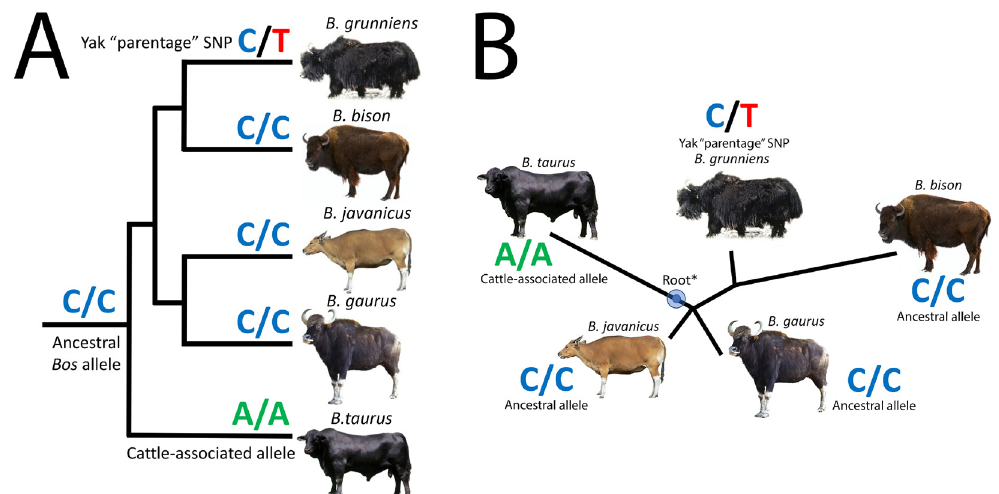
Figure 1. Hypothetical genotype distributions of a specialized triallelic SNP for determining yak parentage and estimating B. taurus introgression. Bos species trees are based on those published by Wu et al . (Wu et al ., 2018. Nat Ecol Evol 2, 1139–45). ( A ) Tree based on whole autosome sequences with the randomized axelerated maximum likelihood (RAxML) method. ( B ) Tree based on whole autosome sequences with the accurate species tree algorithm (ASTRAL) method with a 100-Kb non-overlapping sliding window. *The tree is rooted at the base of the water buffalo ( Bubalus bubalus ) branch.